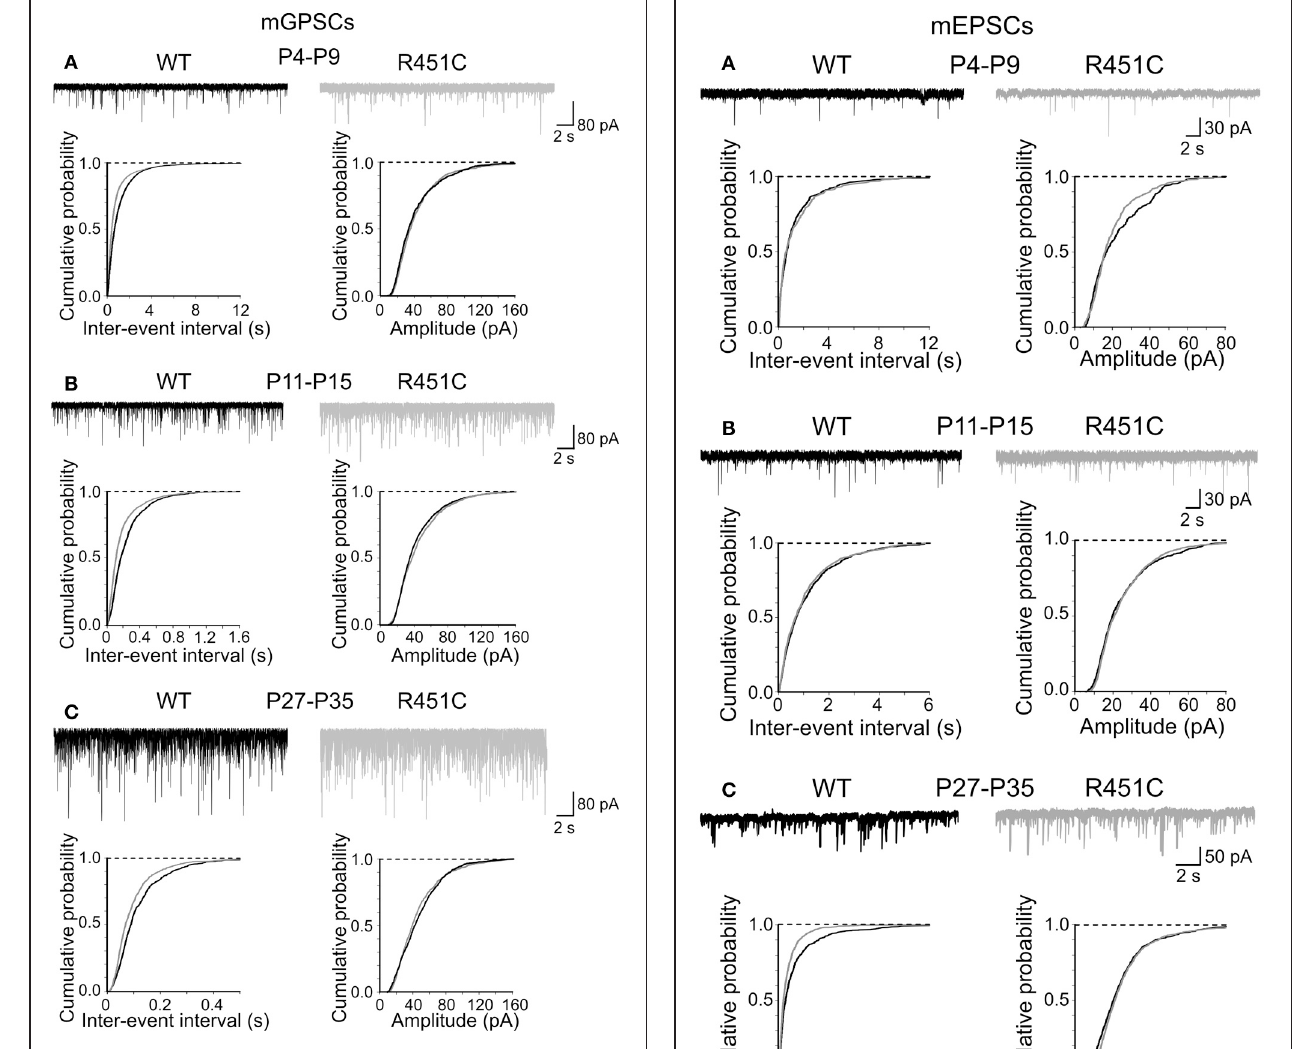
FIGURE 2 | The NL3 R451C knock-in mutation enhances the frequency of mGPSCs. Samples traces of mGPSCs recorded from CA3 principal cells at P4–P9 (A) , P11–P15 (B) and P27–P35 (C) from WT (black) and in NL3 R451C knock-in mice (gray). Below, cumulative probability plots of inter-event intervals (left) and amplitude (right) of obtained from WT and NL3 R451C knock-in mice. Changes in inter-event-interval ( p < 0 . 05; K–S test) but not in amplitude ( p > 0 . 05; K–S test) were significantly different at all developmental stages examined.